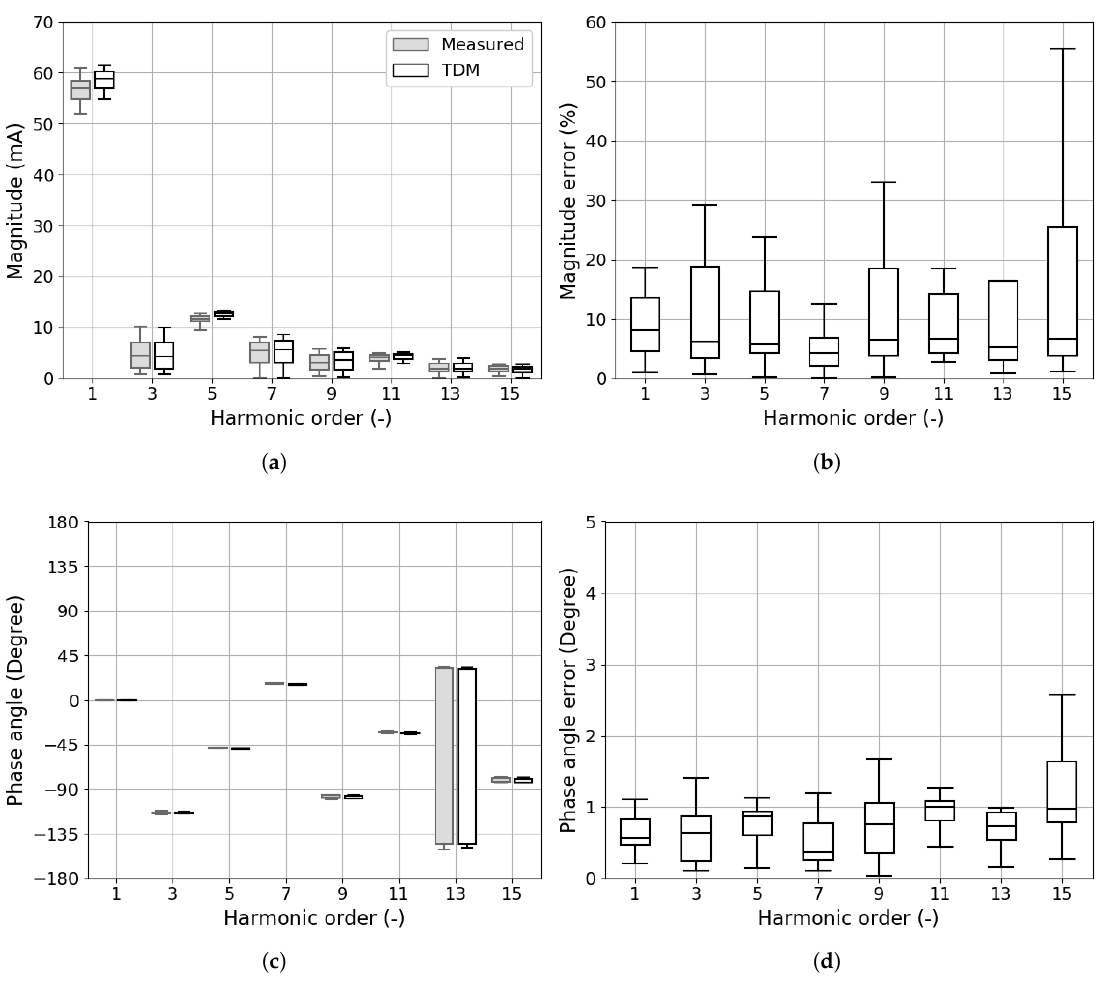
Figure 6. LED Type C: Comparison of the time-domain model (TDM) and the measured data for all test points: ( a ) Magnitude; ( b ) Magnitude error; ( c ) Phase angle; and ( d ) Phase angle